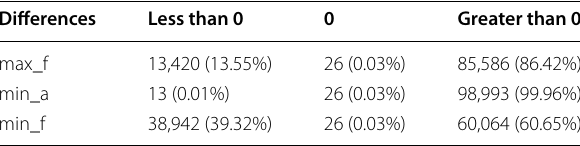
Table 3 Number and percentage of Census Blocks with differences in the accessibility scores computed from 2SVCA and E2SVCA methods